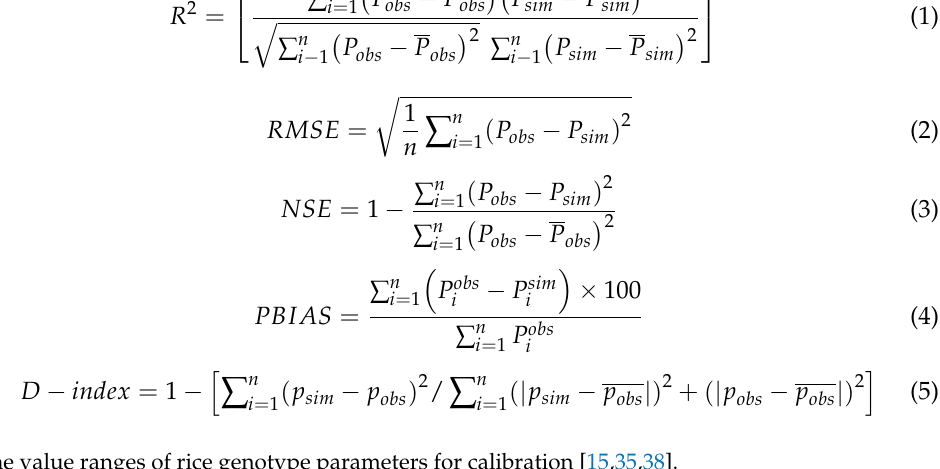
Table 1. The value ranges of rice genotype parameters for calibration